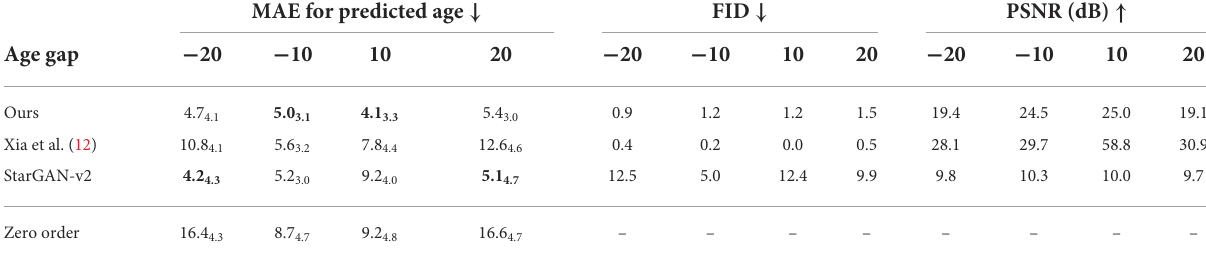
TABLE 3 Mean absolute error (MAE) for age prediction and image quality metrics (FID and PSNR) for synthetically generated images from a subset of subjects with 60 and 70 years old (for an age gap of 10) and with 55 and 75 years old (for an age gap of 20). MAE for predicted age ↓ FID